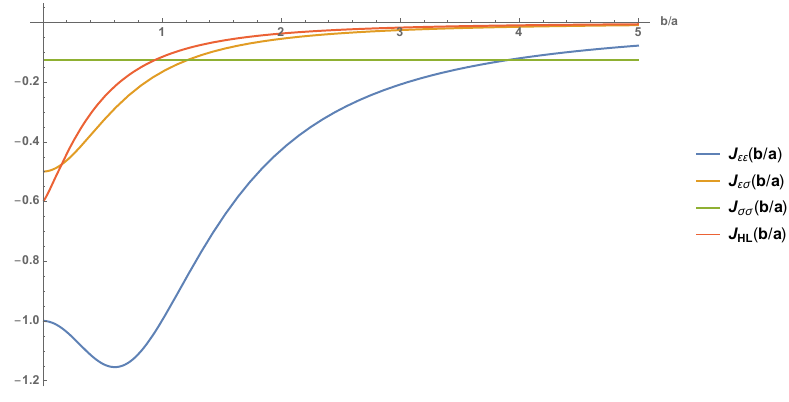
Figure 47 . Plots of J ( b=a ) in our examples. We used h